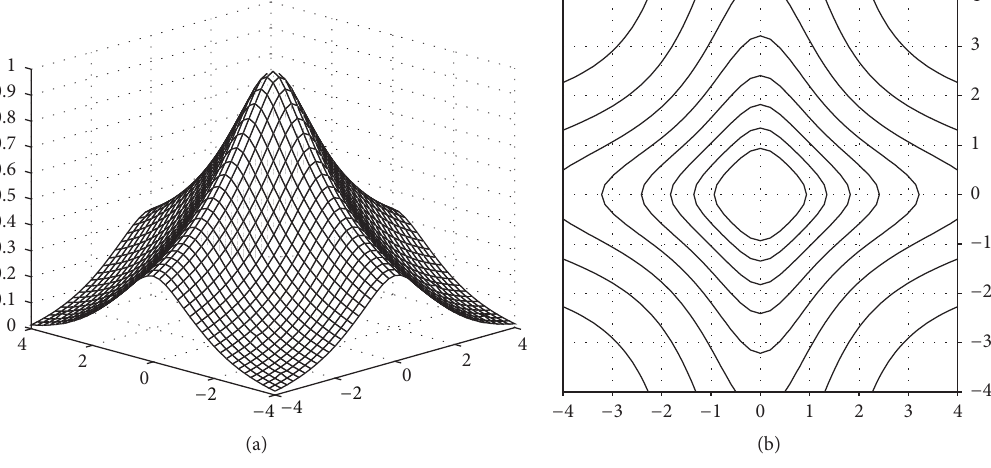
Figure 2: 𝜙 𝑔 with w = 0.25 (a) and its level sets (b). 0 , w